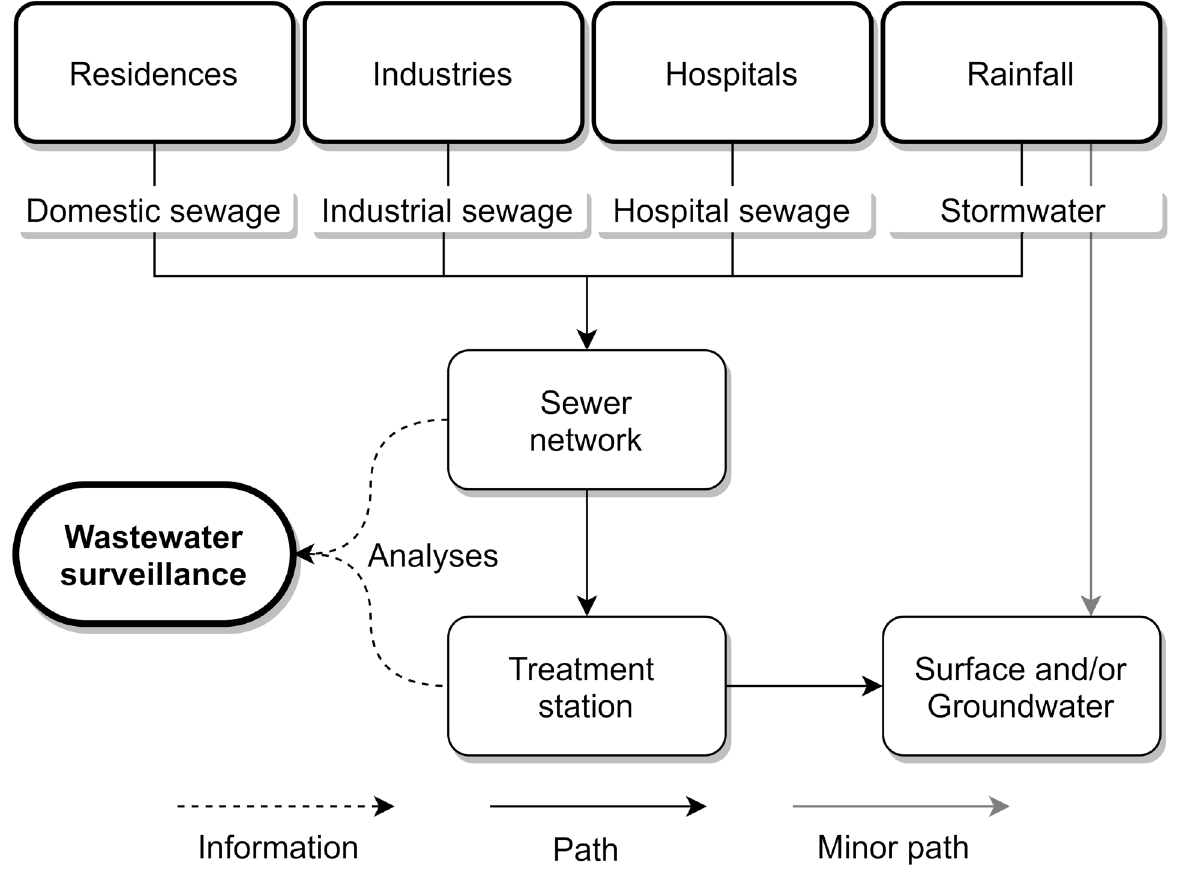
Figure 2. Schematic diagram of wastewater-based epidemiology as a surveillance